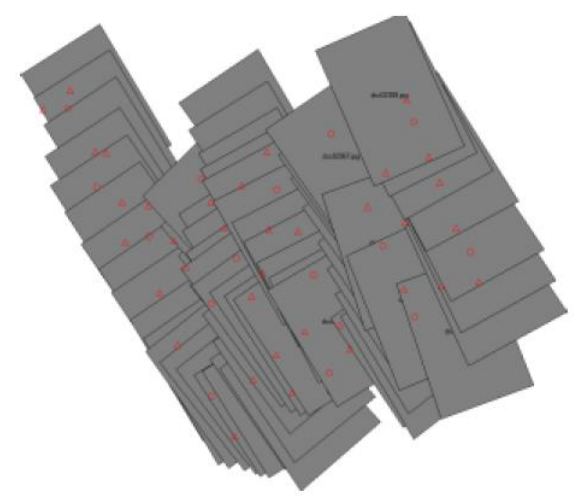
Figure 7. The oriented highest photogrammetric